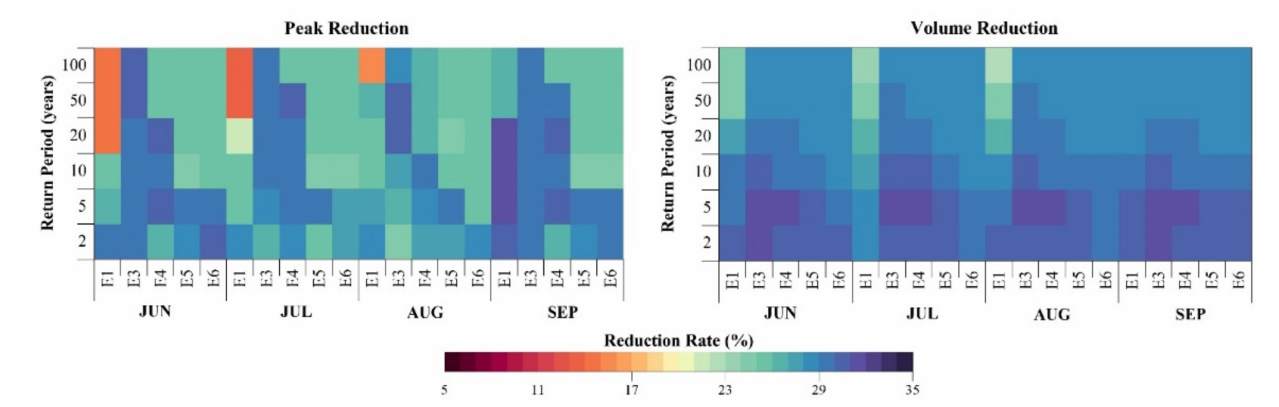
Figure 11. Different peak timing flood control